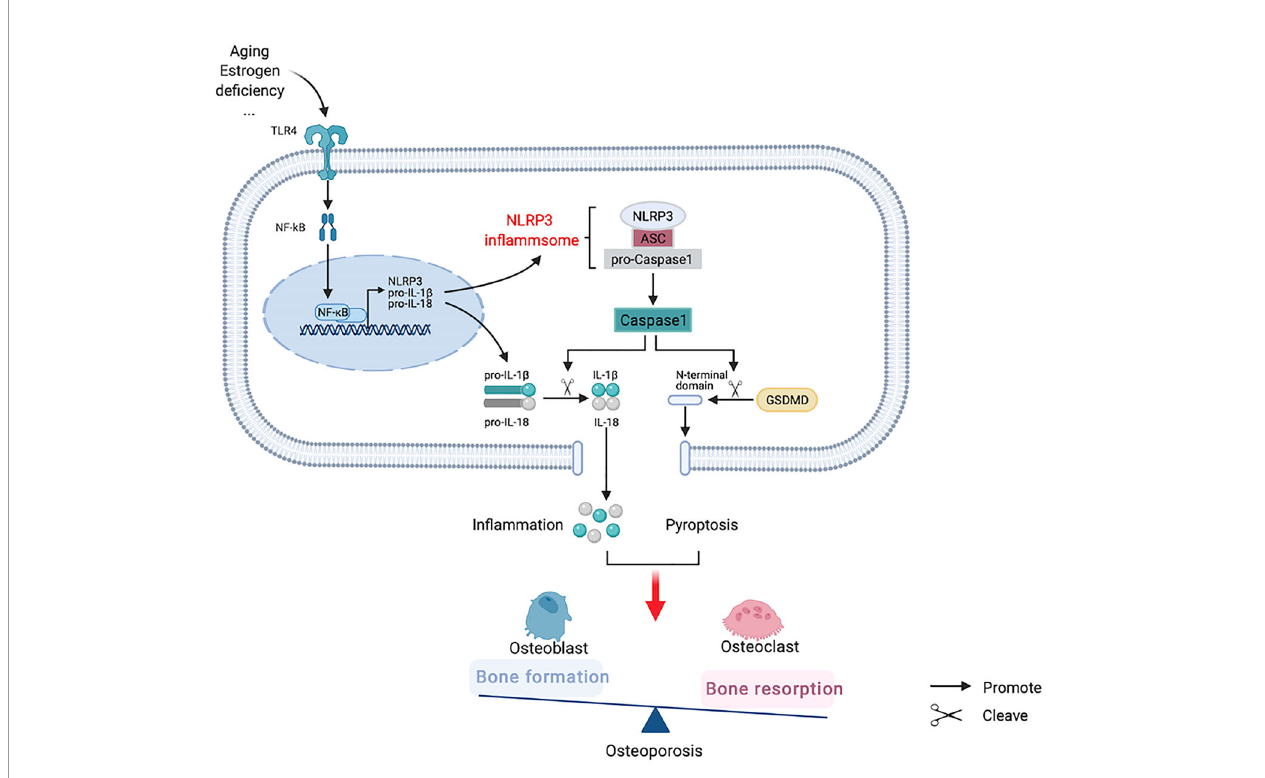
FIGURE 4 | Hypothesized participation of nucleotide-binding oligomerization domain-like-receptor family pyrin domain-containing 3 (NLRP3) in fl ammasome in the pathogenesis of